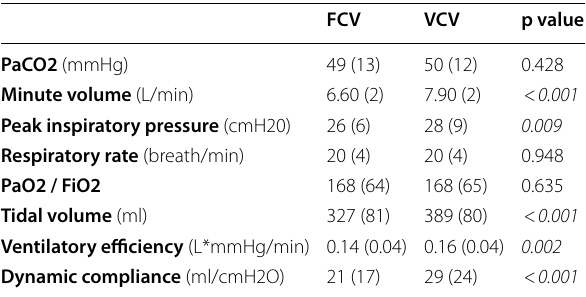
Table 1 Respiratory mechanics measured during each ventilation mode. Data is represented as median (IQR). Statistics were performed with the Wilcoxon rank sum test Conclusion. Ventilation with a controlled expiratory flow resulted in a significantly improved ventilatory efficiency compared to conven- tional volume controlled ventilation in patients with moderate